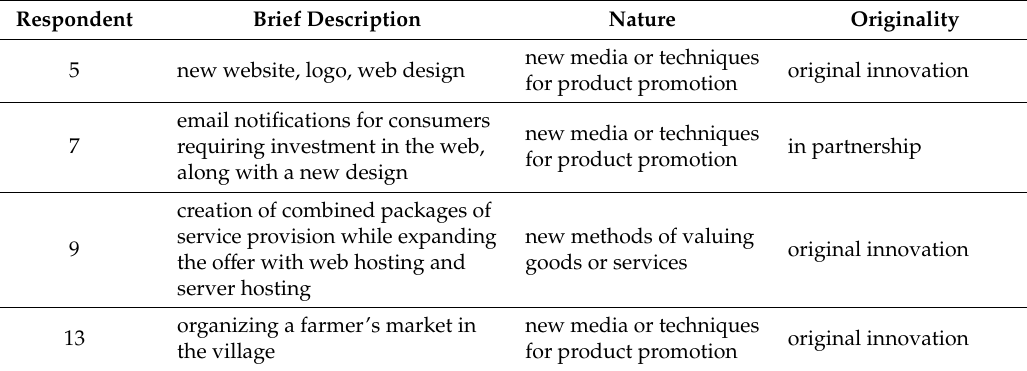
Table 9. An overview of marketing innovations in the